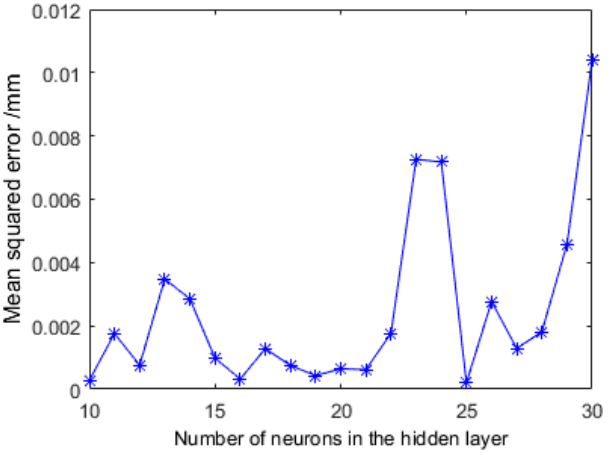
Figure 14. Relationship between the test error and number of neurons in the hidden layer.